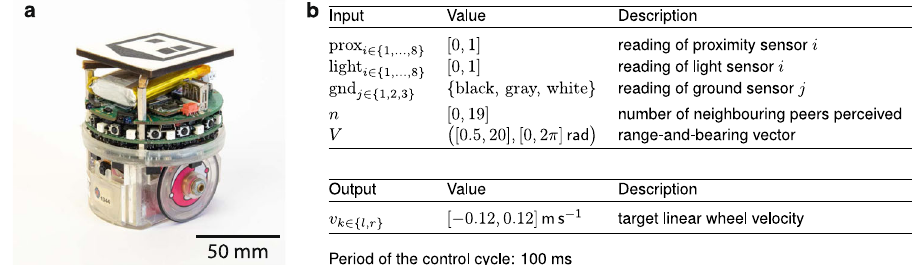
Fig. 1 The robot and its reference model. a The e-puck robot in the con fi guration used for the experiments presented in the paper. Details are provided in “ Methods ” . b The reference model RM 1.1, which formally describes the programming interface through which, in the experiments presented in the paper, the control software interacts with the underlying hardware. The range-and-bearing vector points to the aggregate position of the neighboring peers perceived; its magnitude increases with the number of neighboring peers perceived and decreases with their distance. Formally, V ¼ ∑ n m ¼ where r m and ∠ b m are range and bearing of neighbor m , respectively. If no neighboring peer is perceived, the vector points in front of the robot and has unitary magnitude; formally, V = (1, ∠ 0).